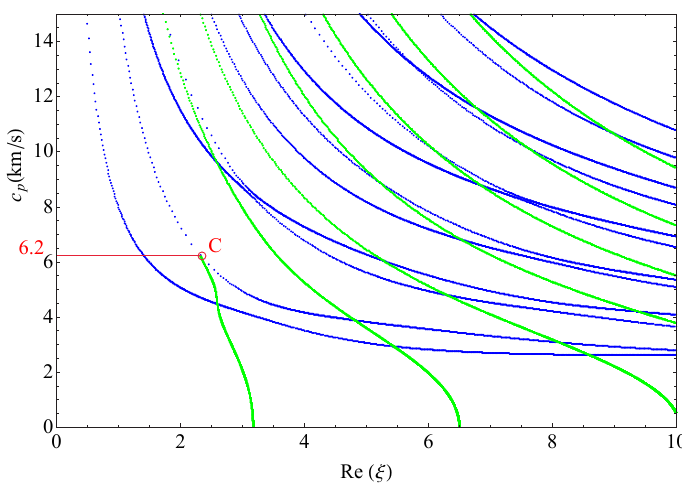
Figure 20. Phase velocity spectra without electric field ( n =